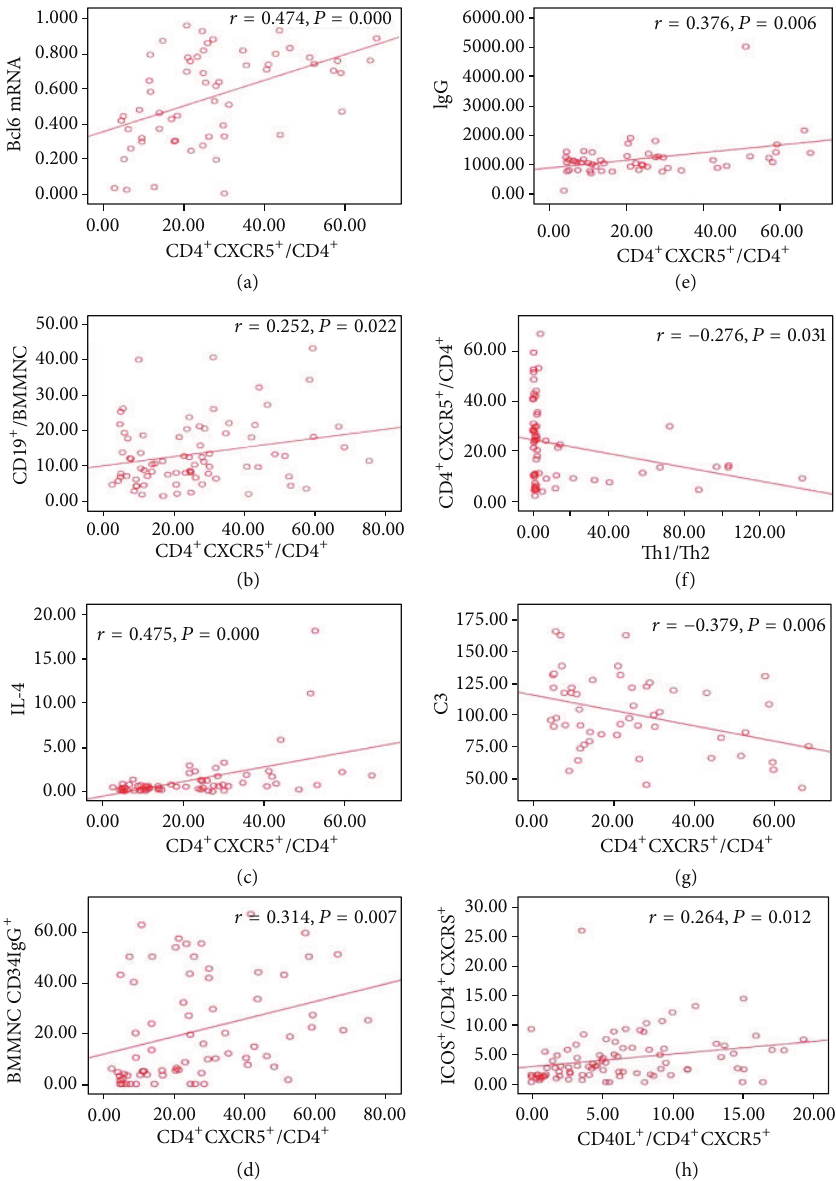
Figure 4: Correlation of Tfh cells frequency in BM and clinical evidence in IRP patients. (a) Relationship between the frequency of the BM CD4 + CXCR5 + Tfh cells and the expression of Bcl-6 mRNA in IRP group. (b) Relationship between the frequency of the BM CD4 + CXCR5 + Tfh cells and the ratio of CD19 + /BMMNC in IRP group. (c) Relationship between the frequency of the BM CD4 + CXCR5 + Tfh cells and the ratio of CD3 + CD8 − IL-4 + /CD3 + CD8 − in IRP group. (d) Relationship between the frequency of the BM CD4 + CXCR5 + Tfh cells and the ratio of CD34 + IgG + /BMMNC in IRP group. (e) Relationship between the frequency of the BM CD4 + CXCR5 + Tfh cells and the total serum IgG level in IRP group. (f) Relationship between the frequency of the BM CD4 + CXCR5 + Tfh cells and the ratio of Th1/Th2 in IRP group. (g) Relationship between the frequency of the BM CD4 + CXCR5 + Tfh cells and the level of serum C3 in IRP group. (h) Scatterplot of the percentage of CD4 + CXCR5 + ICOS + cells versus CD4 + CXCR5 + CD40L + cells from 90 IRP patients showing a